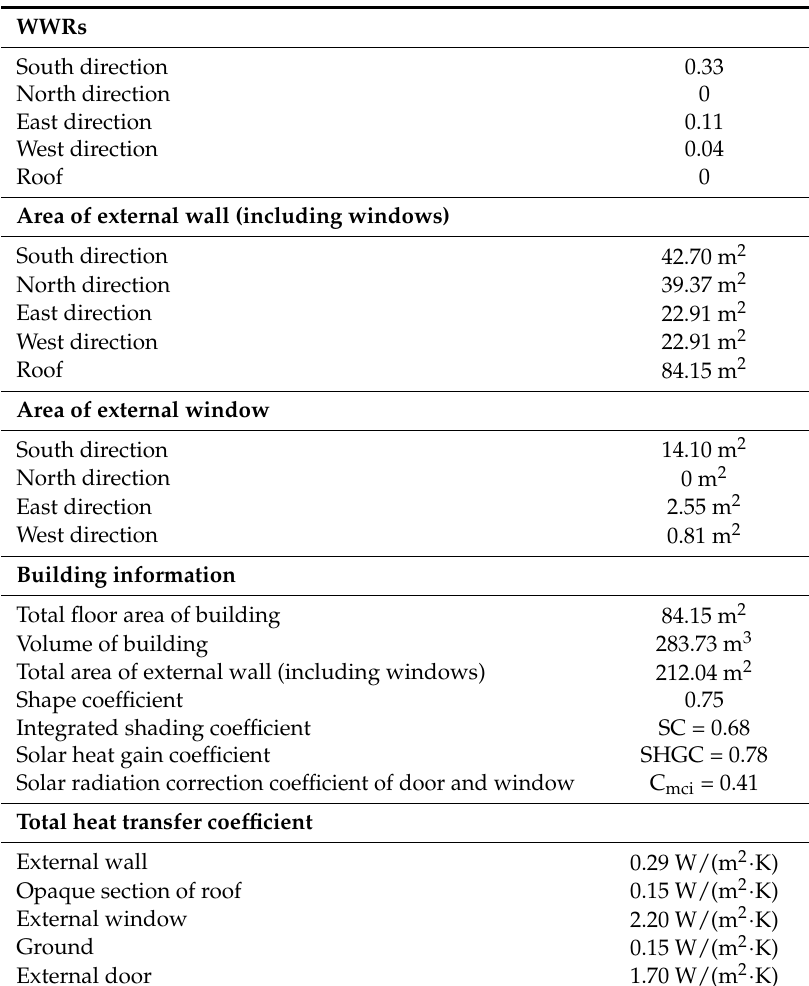
Table 1. Structural and thermal parameters of building